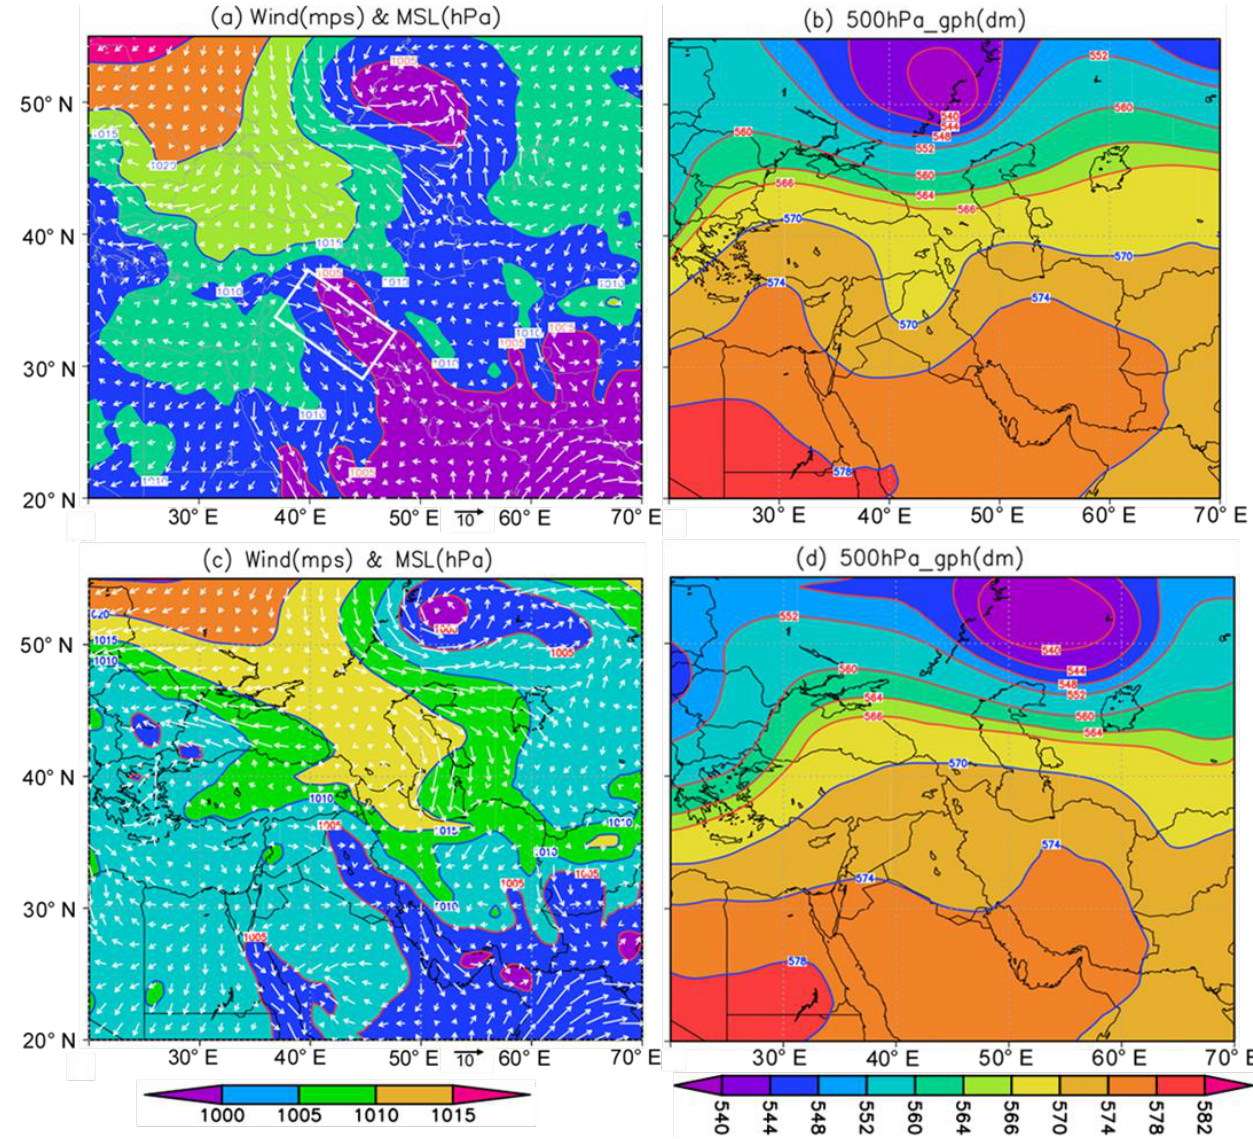
Figure 3. ( a ): Sea level pressure (shaded as in the legend and solid color contours, interval is 5 mb), wind (ms −1 ), and ( b ): 500-hPa geopotential height (shaded as in the legend and solid red and blue contours, interval is 4 dam) at 00UTC on 15 September 2008. ( c ): sea level pressure and ( d ): 500-hPa geopotential height at 00UTC on 16 September 2008. The white rectangle on figure ( a ) shows the area of strong northwesterly winds (Shamal winds).